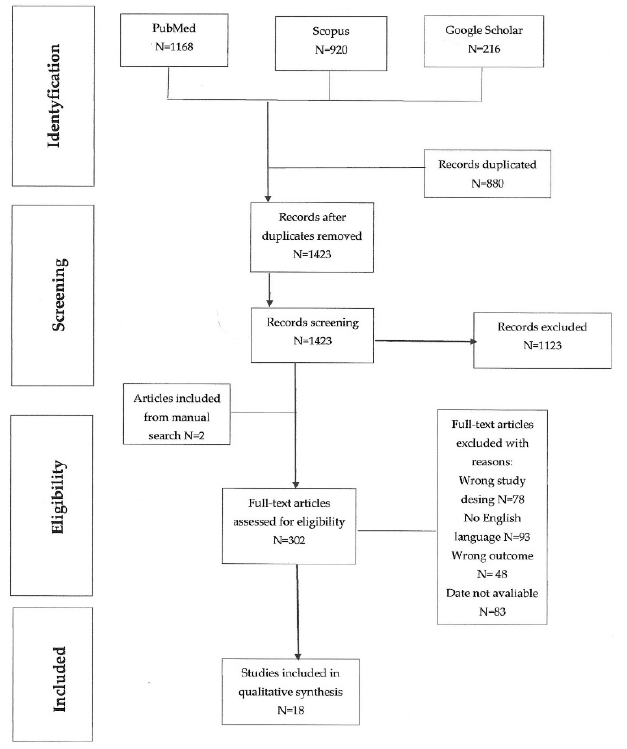
Figure 1. Flow chart of data extraction throughout the databases.